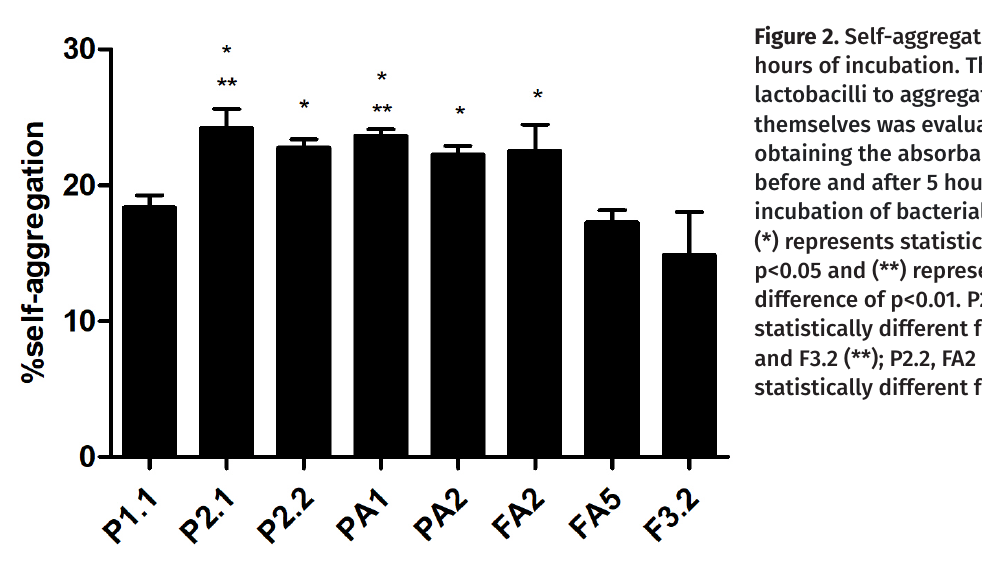
Figure 1. Classification of strains according to the degree of hydrophobicity. The hydrophobicity was evaluated from the incubation of the lactobacilli suspension with xylene and the degree of hydrophobicity was calculated from the absorbance values obtained before and after 2 hours of incubation. (*) represents statistical difference of p<0.05, (**) represents statistical difference of p<0.01 and (***) represents statistical difference of p<0.001. PA2 is statistically different from FA2 (**) and all other six strains studied (***); FA2 is statistically different from P2.2 (***) and all strains classified as low hydrophobicity (***); P2.1 and PA1 are statistically different from P2.2 (*) and all strains classified as low hydrophobicity (***); P2.2 is statistically different from all strains classified as low hydrophobicity (***) and F3.2 is statistically different from P1.1 (*).